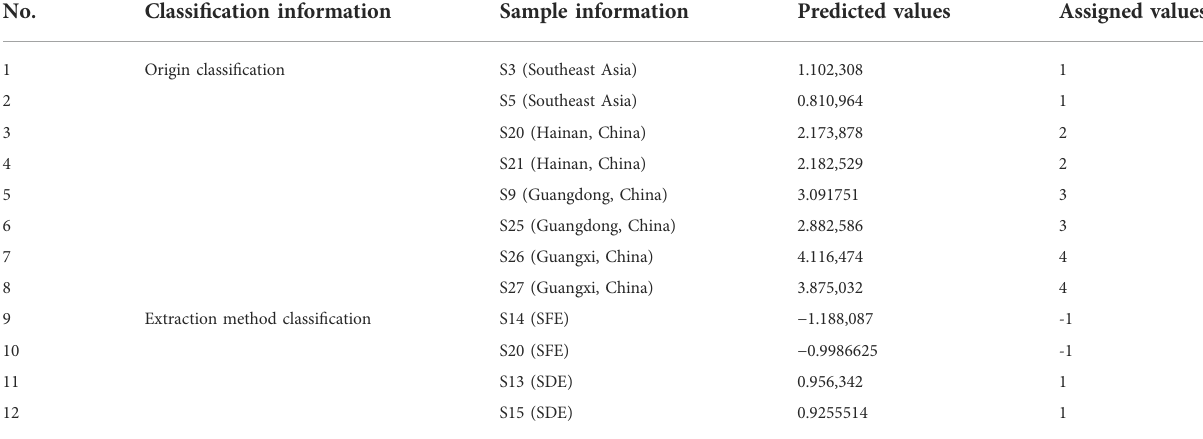
TABLE 4 Predicted results of the PLS discriminant model in validation